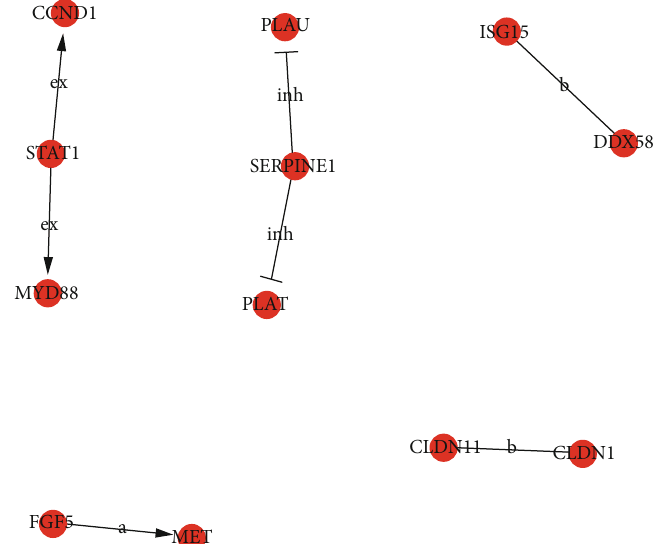
Figure 6: Analysis of the interaction network of di ff erentially expressed genes (Signal-net) in the KDM3B overexpression group compared with the control group. In the Signal-net, the intermediate centrality of genes represents the characteristics of genes. Red represents an important upregulated gene, and the degree of interaction between genes is indicated by the circle size and the interaction is indicated by the